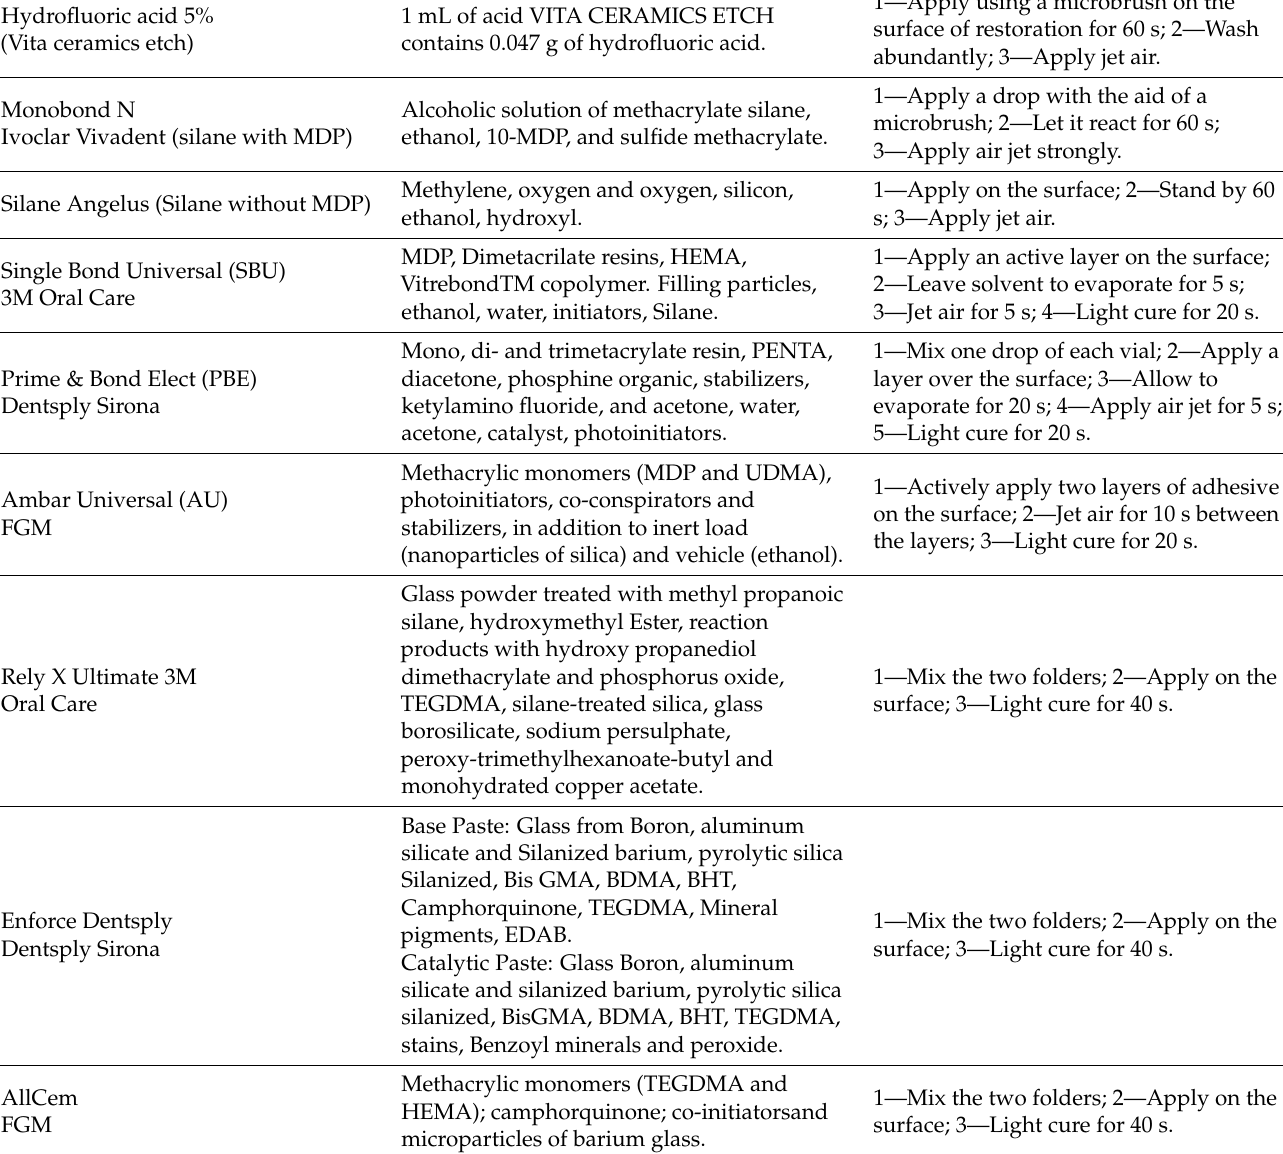
Table 2. Description of the materials, manufacturers, compositions, application method, and indica- tion of the materials used in this